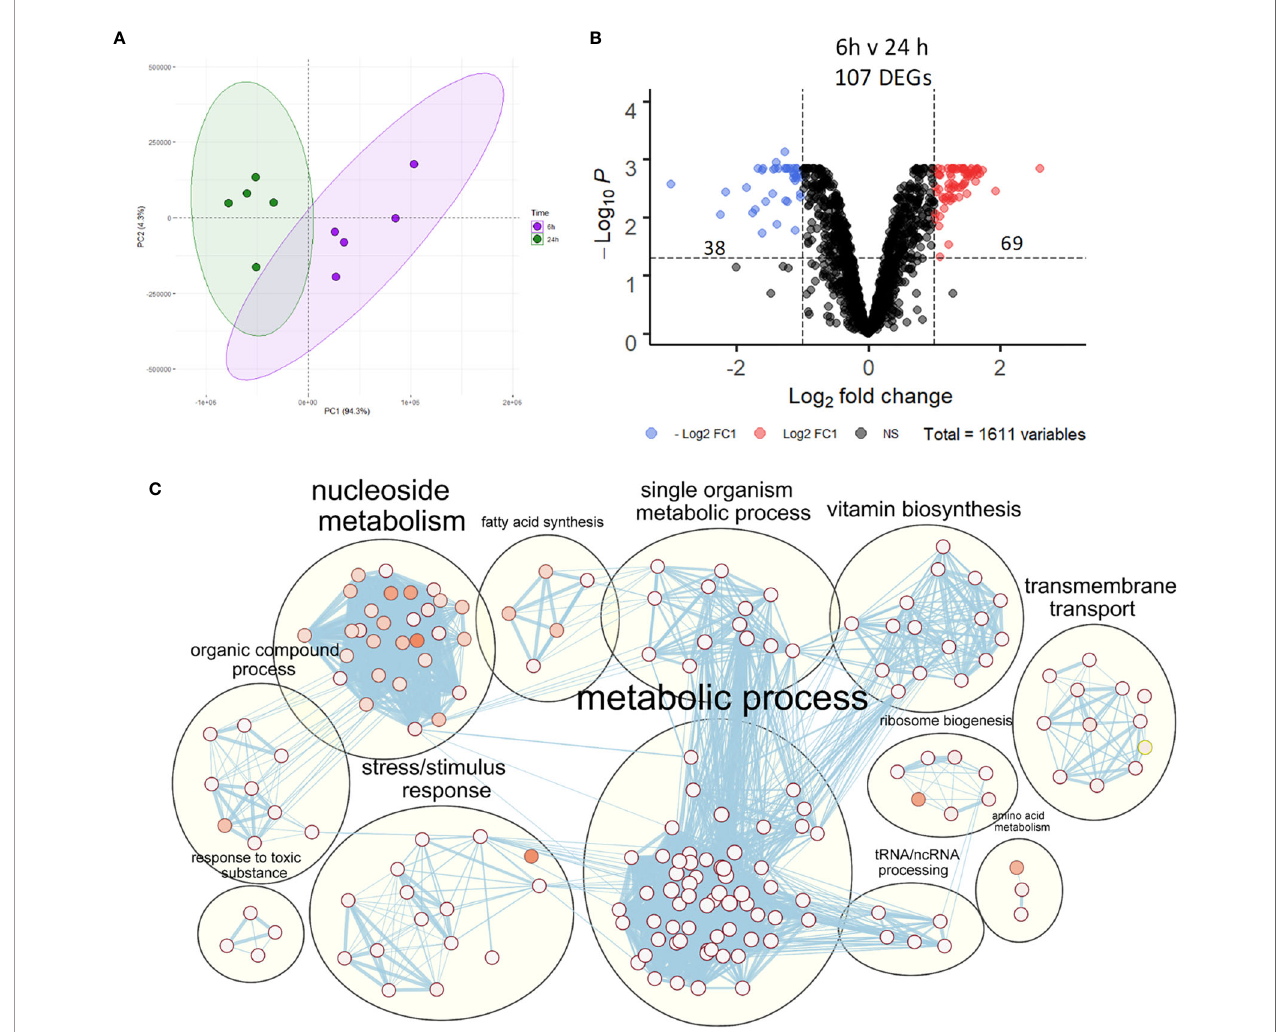
FIGURE 5 | NTHi transcriptomic regulation during adaptation to intracellular persistence. (A) Principal component analysis identi fi ed clustering of NTHi samples based on time point (6 h time point samples in purple and 24 h time point samples in green). (B) Differential gene expression analysis identi fi ed 107 NTHi DEGs at 24 h (log 2 FC1 cut off, FDR p < 0.05). (C) Clustering of the enriched Biological Process GO:terms performed using EnrichmentMap and AutoAnnotate in Cytoscape found enrichment of numerous metabolic processes. Nodes represent individual GO:terms, with size relating to the number of genes in each term and the colour indicating enrichment signi fi cance. Edges represent connections between nodes that share